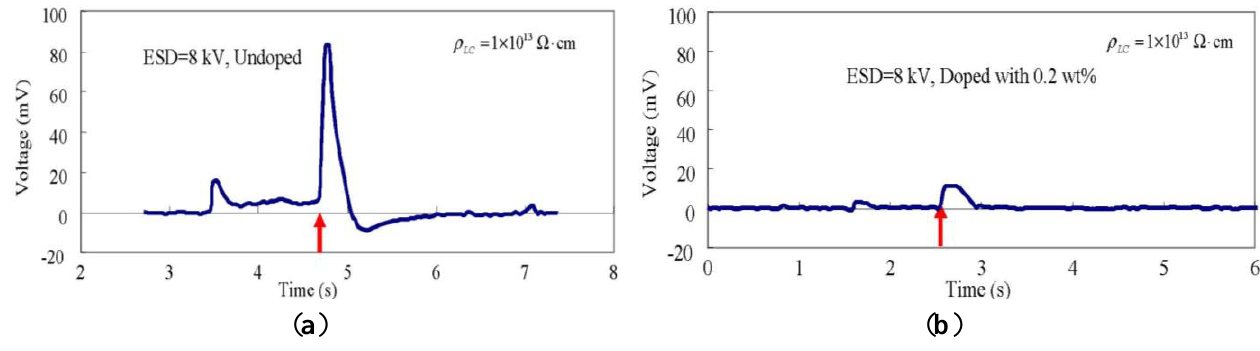
Figure 13. Electrical measurements for the voltage across ( a ) the undoped LC layer and ( b ) the doped layer under attack of an ESD arc. The small peak before the onset of the ESD was identified as the approach of the high-voltage gun, the negative peak indicates the removal of the HV gun.